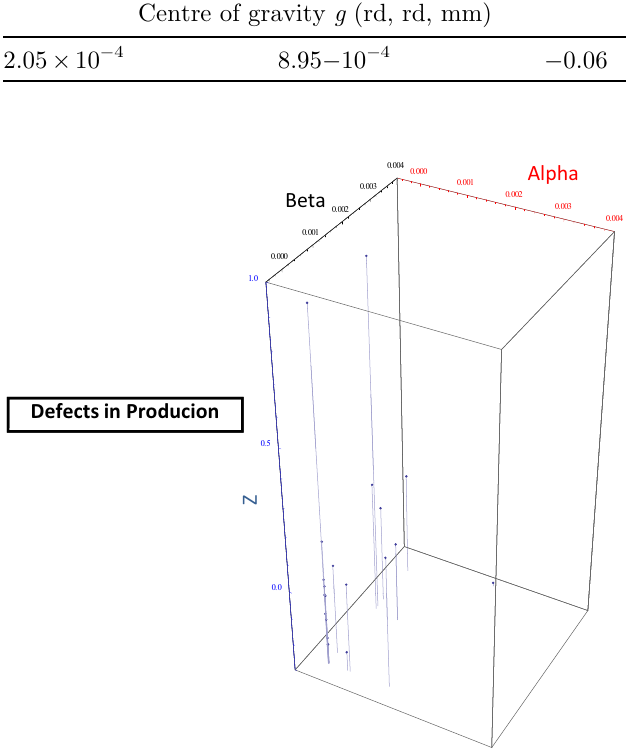
Fig. 7. Spread of the point cloud of defects in production.